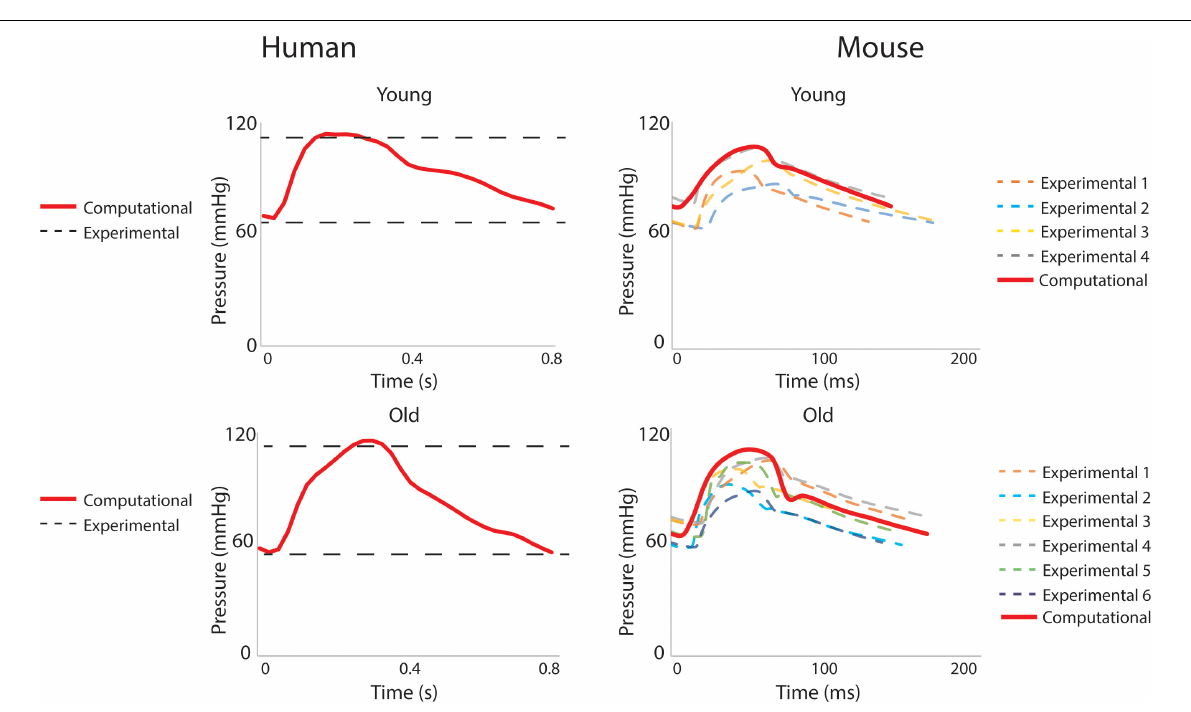
FIGURE 7 | Validation of hemodynamic results using pressure data. For humans, the simulated left subclavian artery pressure (solid red line) compared well with systolic and diastolic pressure cuff values (dashed black lines). For the mice, simulated ascending thoracic aortic (ATA) flow waveforms (solid red lines) compared well with experimental data from multiple subjects (dashed